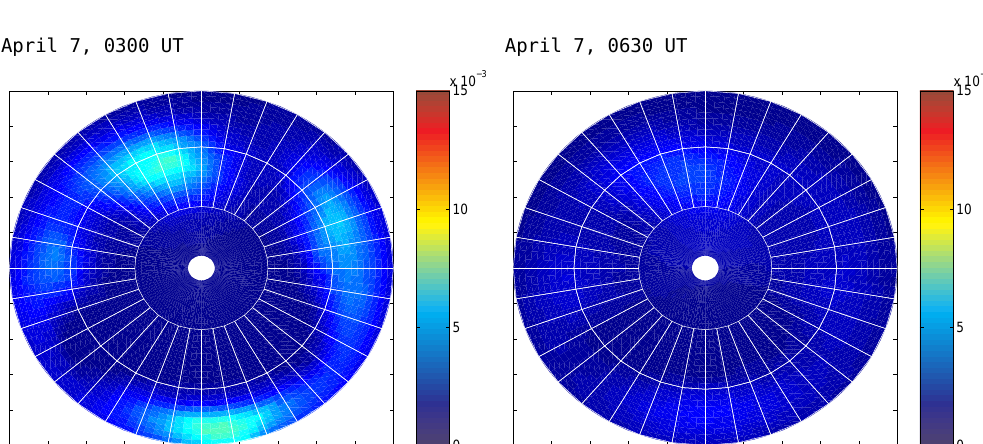
Fig. 5. Precipitation power color-coded in the simulation at six moments of time during the April 2000 storm, units Wm − 2 .